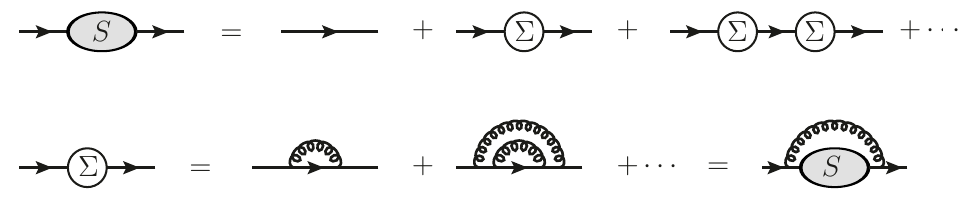
Figure 1 . Dyson-Schwinger equation for the dressed quark propagator in large N